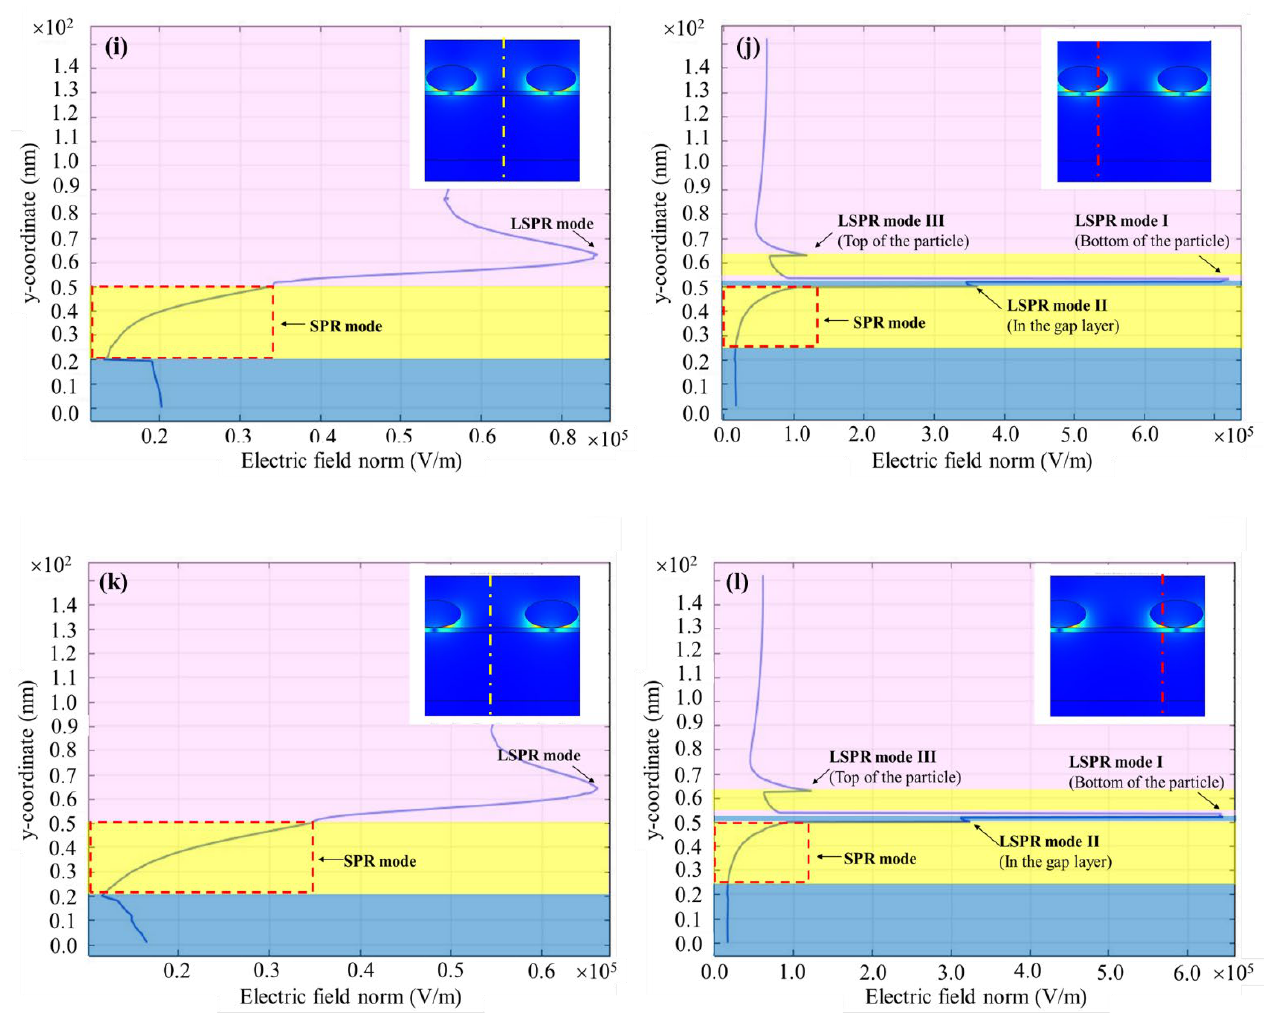
Figure 5. The normal component of the electric field along two different cutlines for different parti- cle separations of 5 nm ( a , b ), 10 nm ( c , d ), 15 nm ( e , f ), 20 nm ( g , h ),25 nm ( i , j ) and 30 nm ( k , l ). Insets showing field profiles for different particle separations.